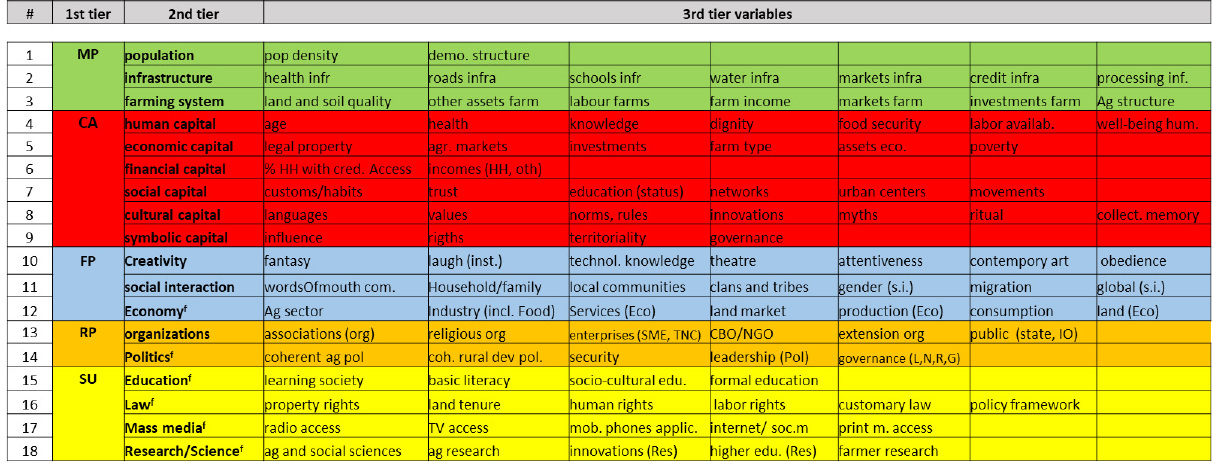
Table 1: Framework of exogenous variables (elements) of Food and Agriculture systems in society, including five mega-structures (1 st tier variables), 18 2 nd tier and 99 3 rd